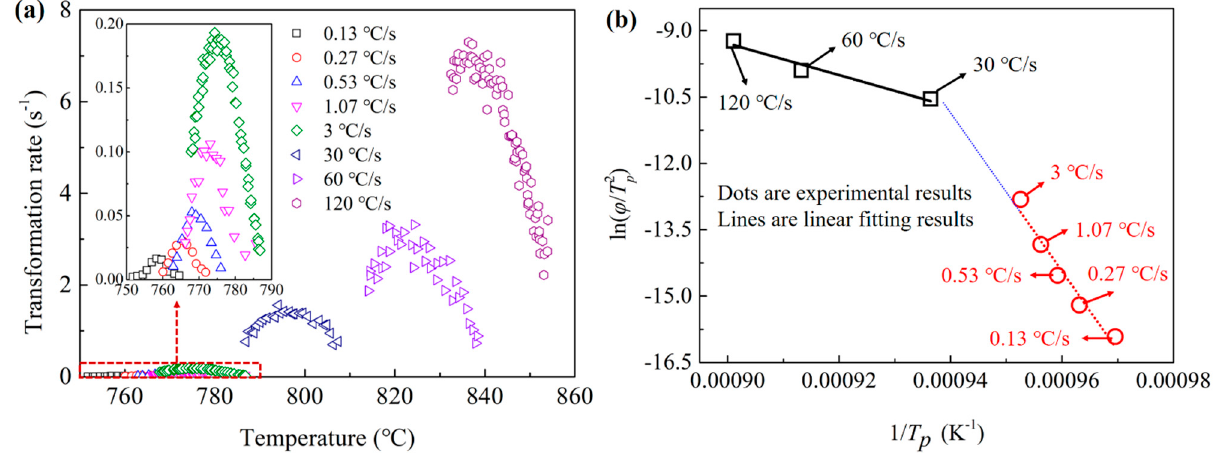
Figure 6. ( a ) The relationships between the transformation rate and temperature; ( b ) the relationships between ln( φ / T p 2 ) and 1/ T p .